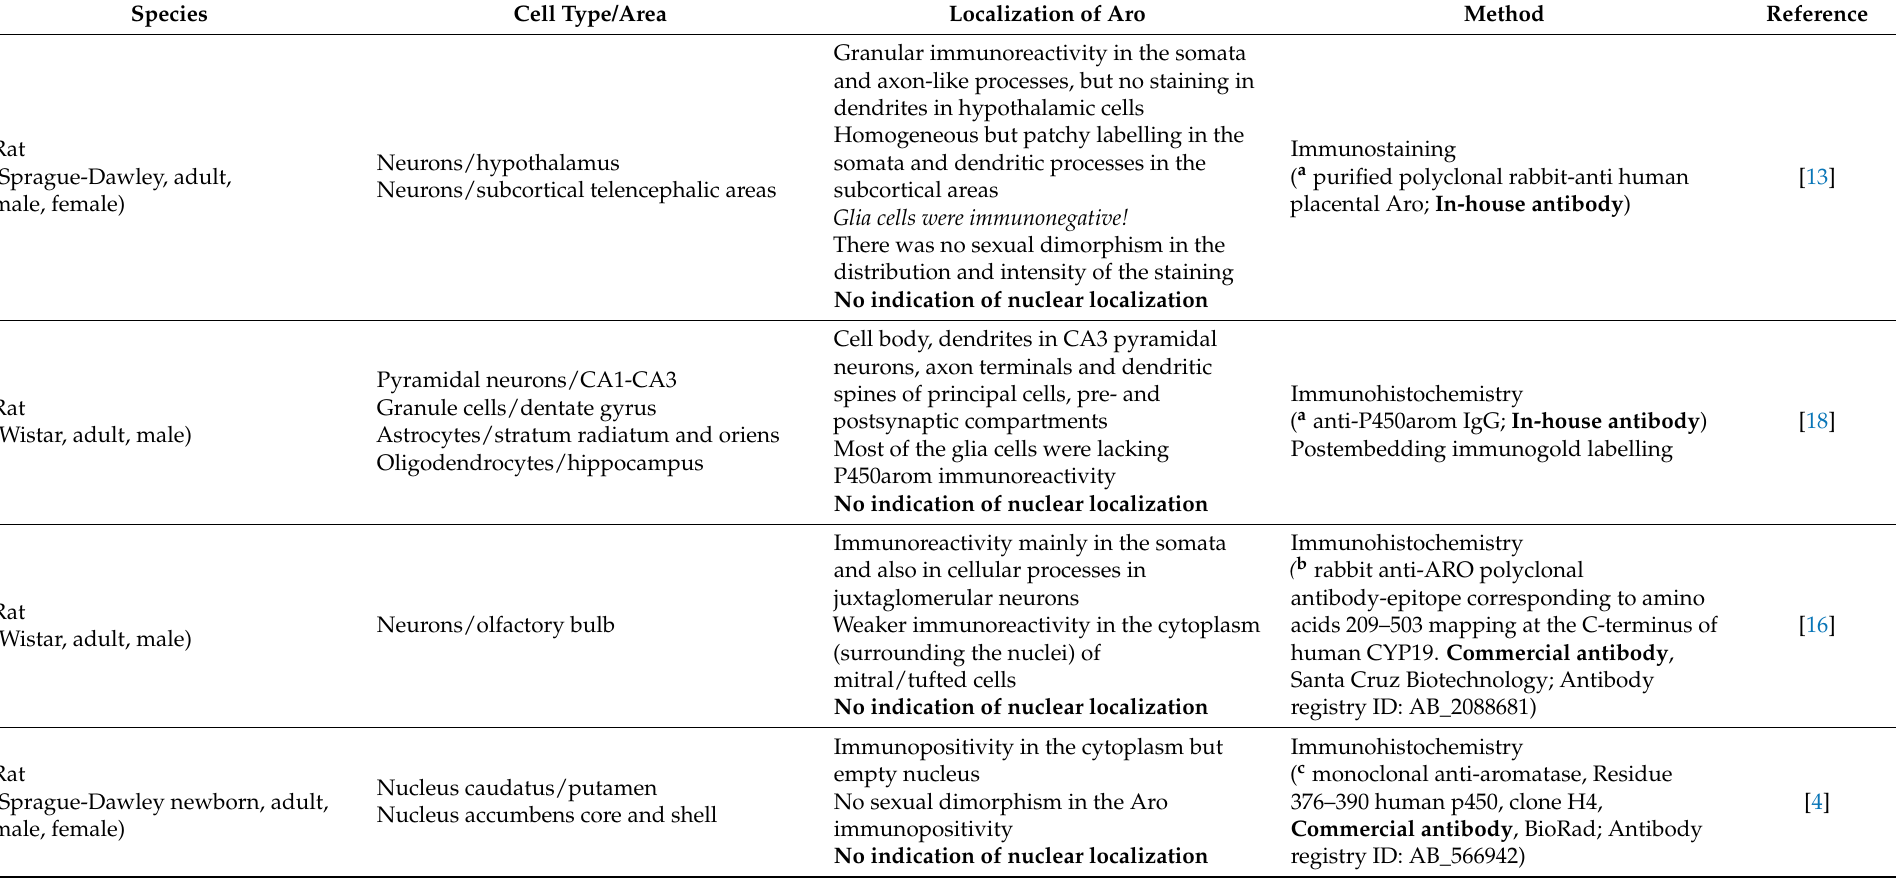
Table 1. Summary of studies investigating aromatase expression in the